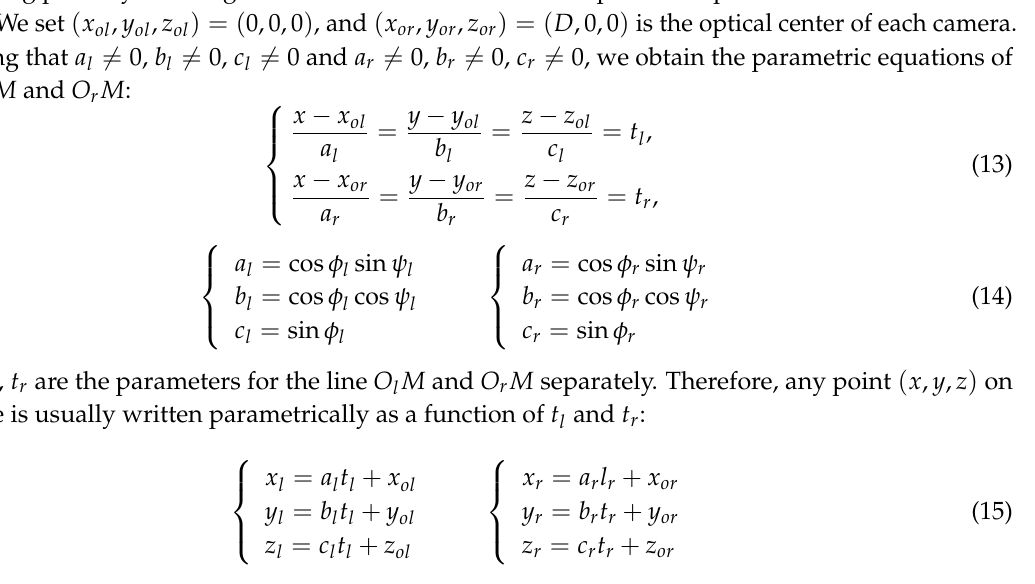
Figure 7. ( a – c ) Vector field distribution of ∇ x quadrant; ( d – f ) gradient of X , Y , Z with θ l and θ r in the second